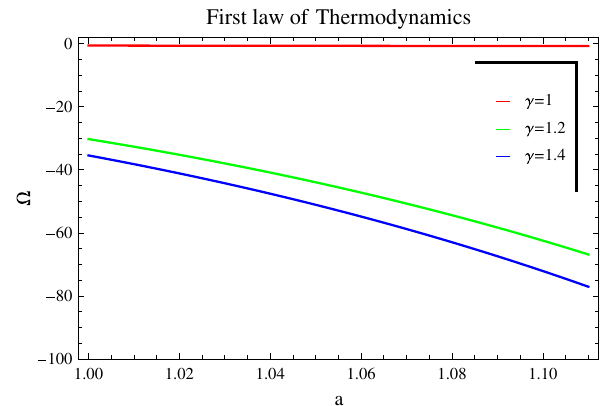
Fig. 10 Plot of (cid:10) versus a for Renyi entropy using k = 1 , λ = − 1 , η = 1 and b = 1